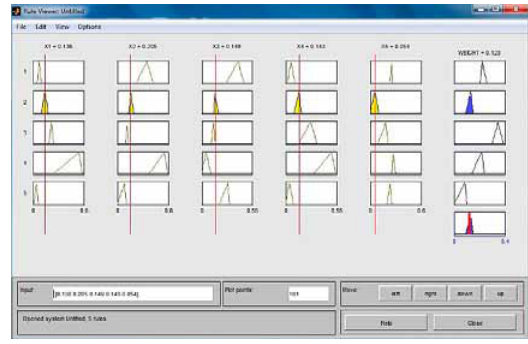
fig. 5. output function a